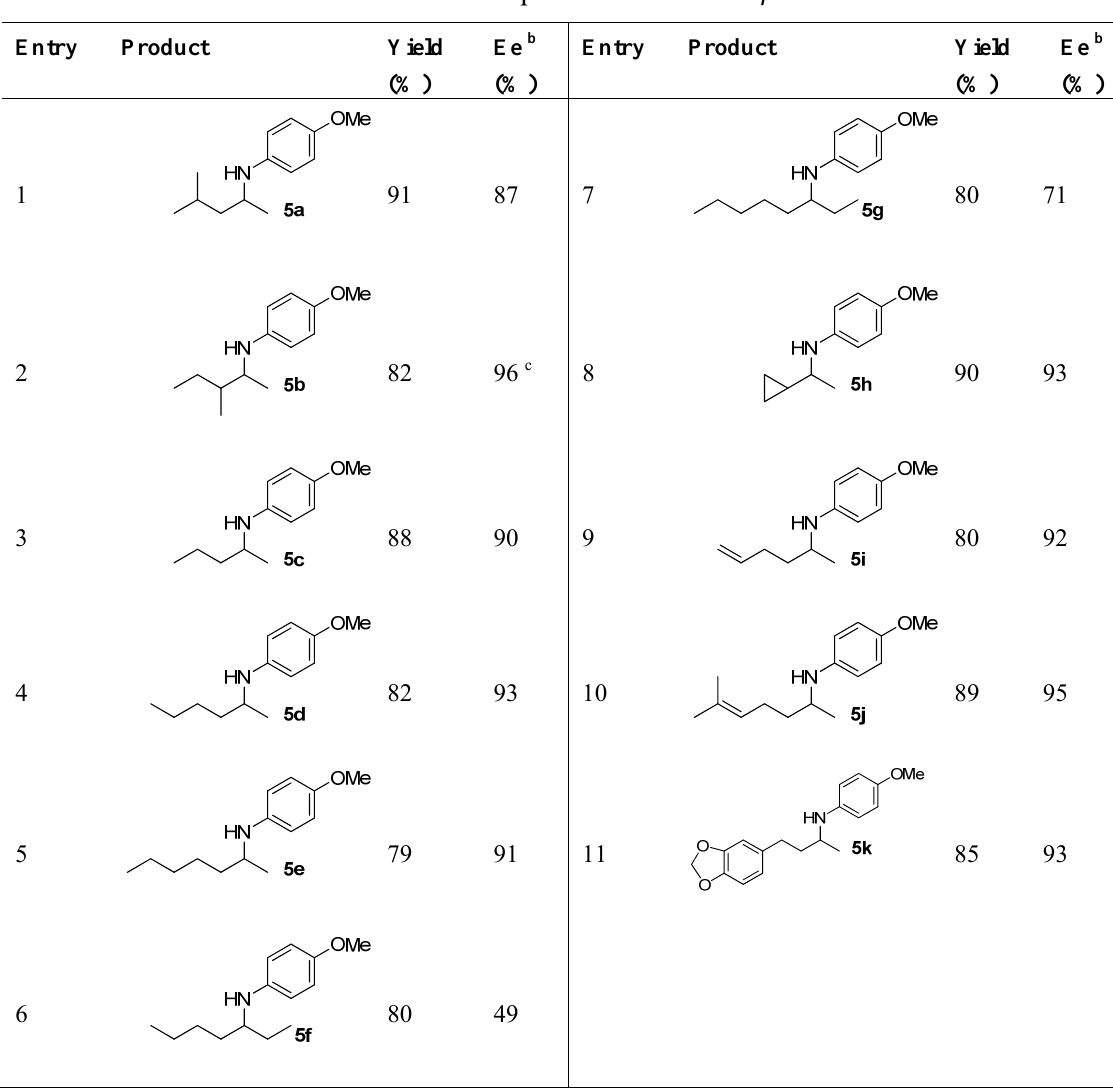
Table 2. DARA of aliphatic ketones with p -anisidine.